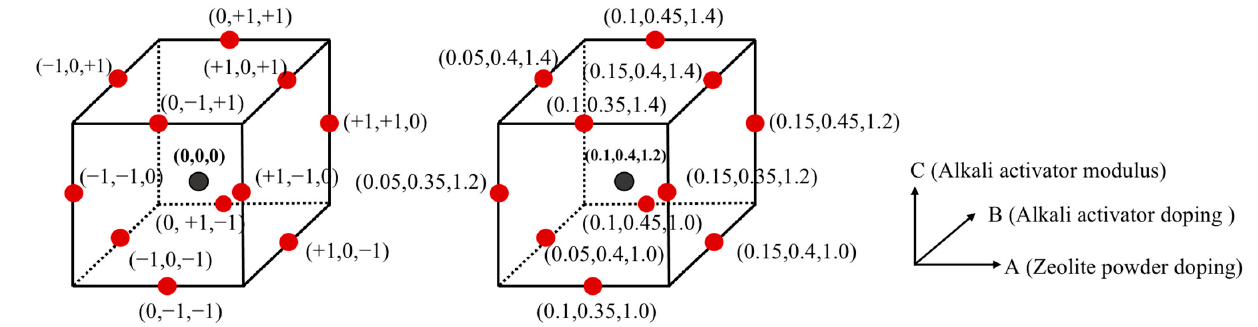
Figure 2. Experimental analysis model of Box–Behnken.